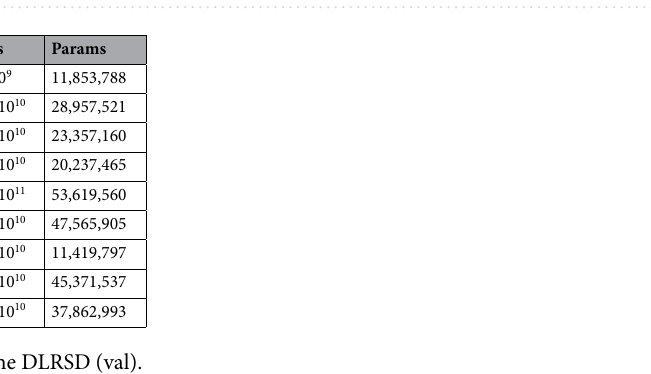
Figure 4. Visualization of CityScapes (val).